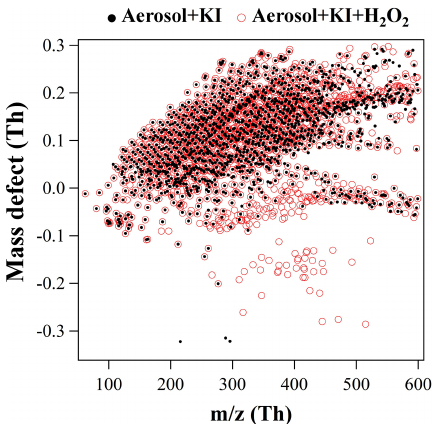
Figure 5. Mass defect (MD) vs. m/z diagram of molecular ions be- fore (black dots) and after (red circles) the addition of H 2 O 2 into aerosol extract + KI mixture. The mass spectrum of all ions above background level (10 4 ) was reconstructed by integrating over reten- tion time 0–15min. Units (Th) are in